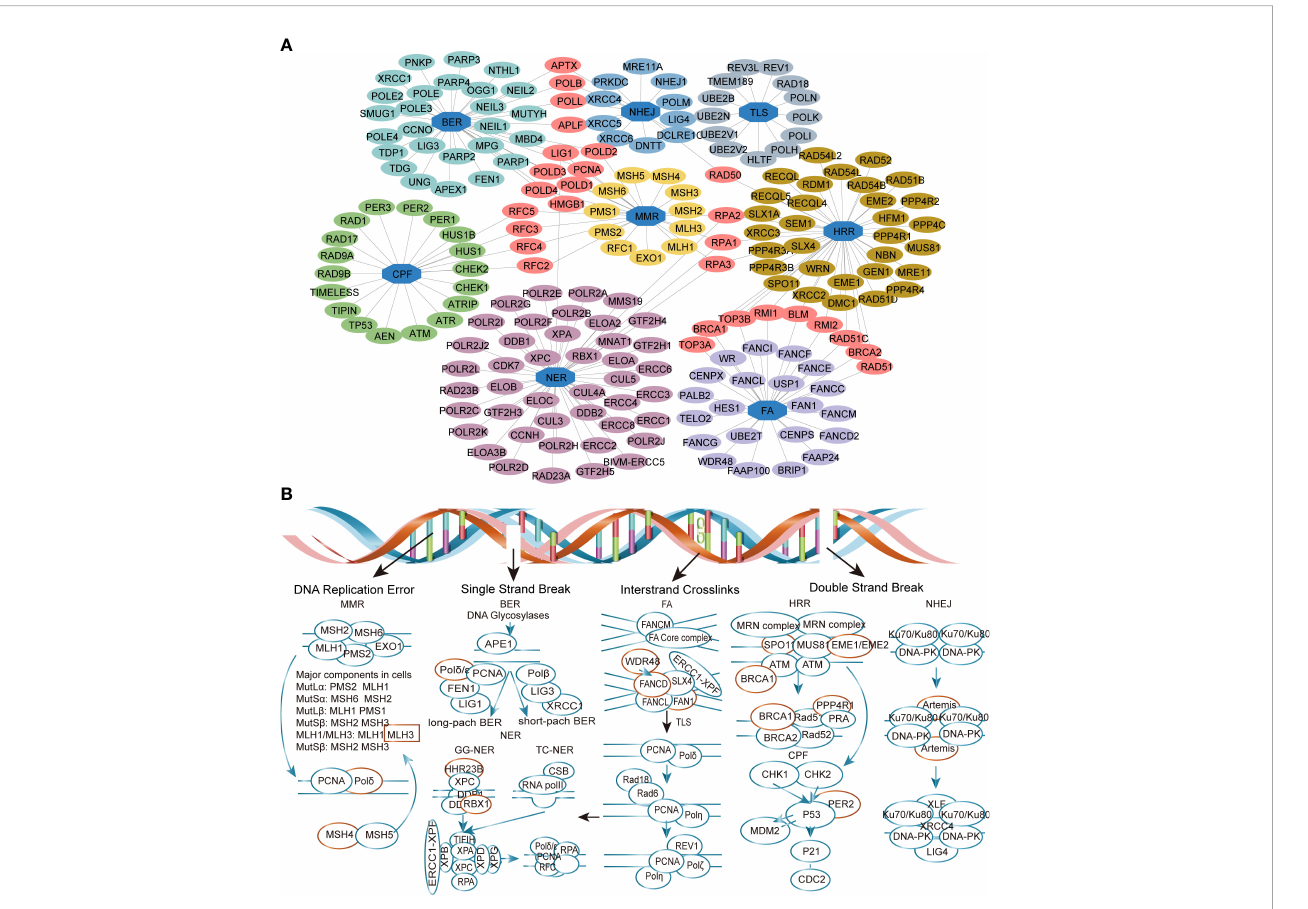
FIGURE 2 Identi fi cation of the differently expressed DDR genes (DEDGs) in metastatic colorectal cancer (mCRC). (A) Co-network of DDR genes in different pathways (B) The DEDGs distributed in the DDR pathway. The red circle represents DEDGs. MMR, mismatch repair; BER, base excision repair; FA, Fanconi anemia; HRR, homologous recombination repair; NHEJ, nonhomologous end-joining; NER, nucleotide excision repair; TLS, translesion DNA synthesis; CPF, checkpoint factors.